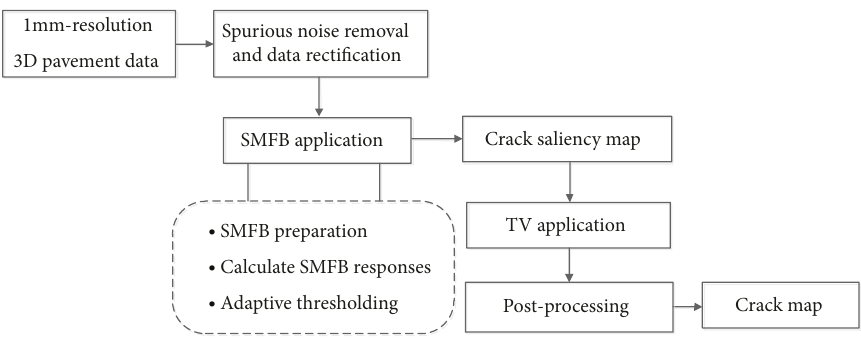
Figure 3: Flowchart of the proposed